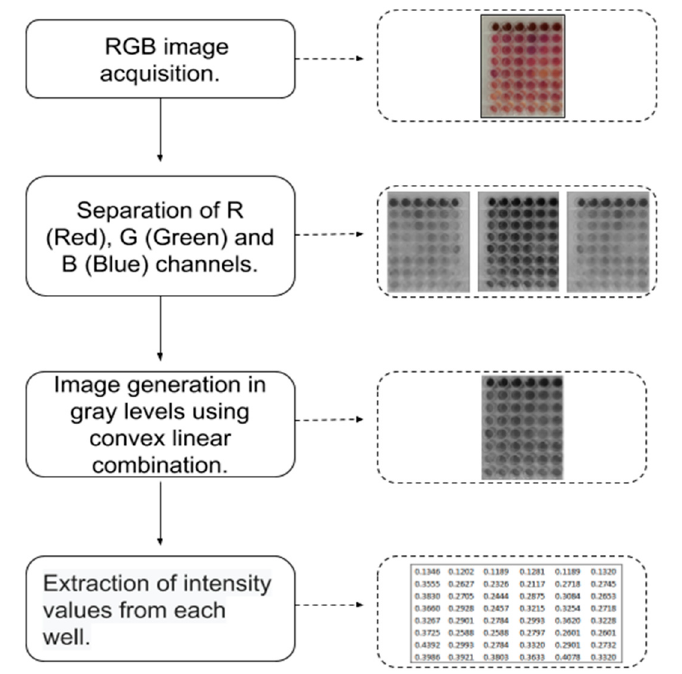
Figure 7. Flowchart of the proposed methodology.